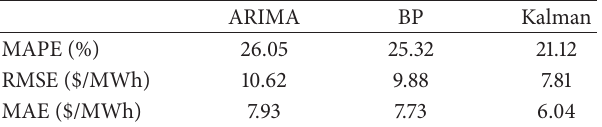
Table 3: Comparison of three individual forecasting